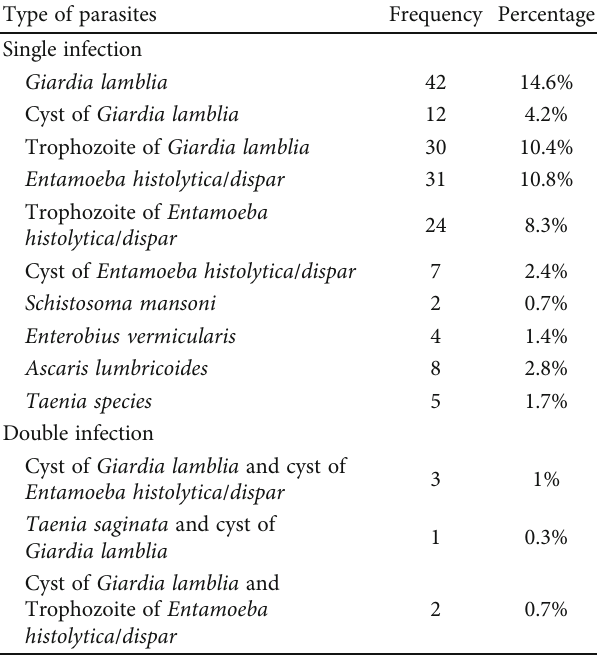
Table 2: Intestinal parasite prevalence among food handlers ( N = 288 ) working in Goba town,